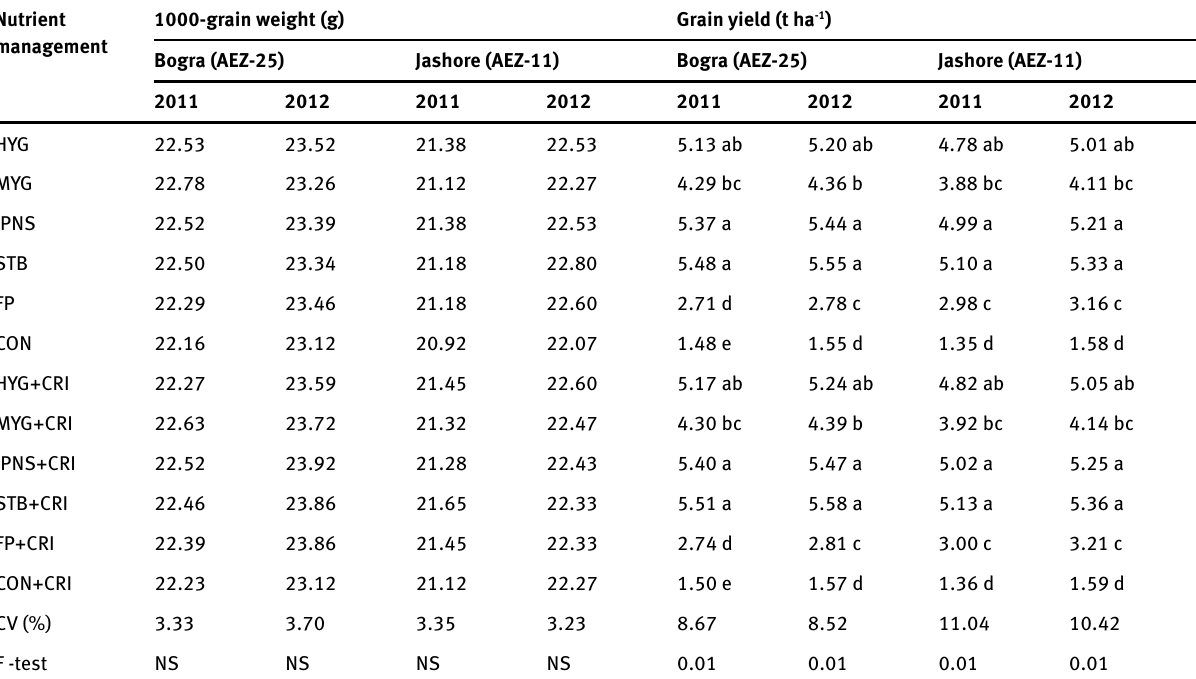
Table 5: Influence of different nutrient management strategies on 1000-grain weight of rainfed monsoon rice at two locations in Bangladesh Nutrient